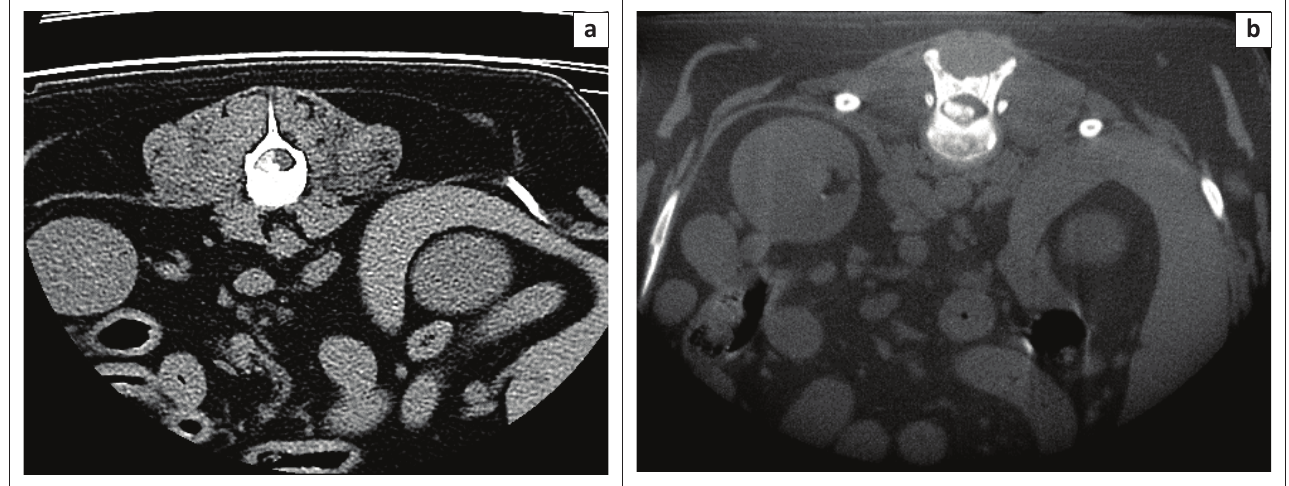
FIGURE 3: Comparative transverse images of an acute intervertebral disc extrusion at the 12th and 13th thoracic vertebrae between the soft tissue spine window (window width of 400 and level of 40) of a multi-slice computed tomography (a) and the high-definition volumetric computed tomography (b) soft tissue window (window width of 350 and level of 50).